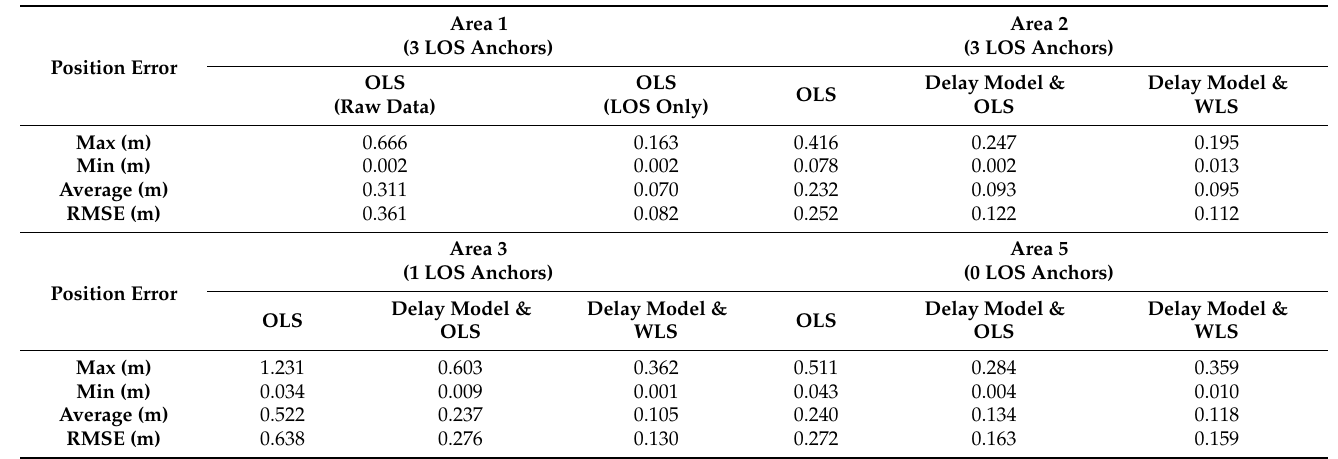
Table 6. Position accuracy analysis for delay model with WLS (Experiment